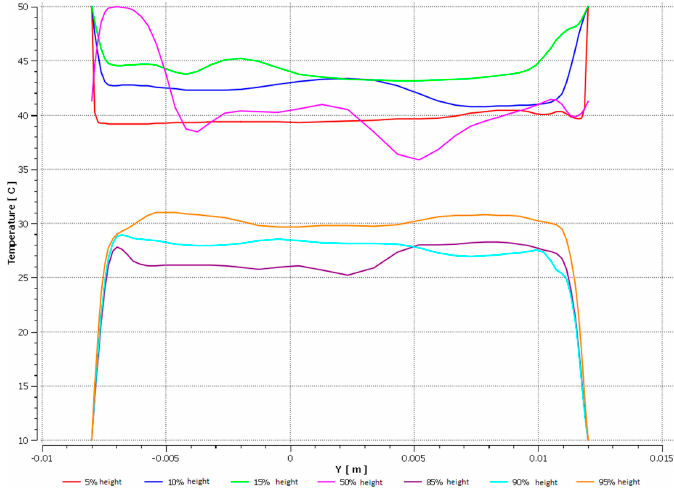
Figure 30. Temperature distribution along the cross-section.